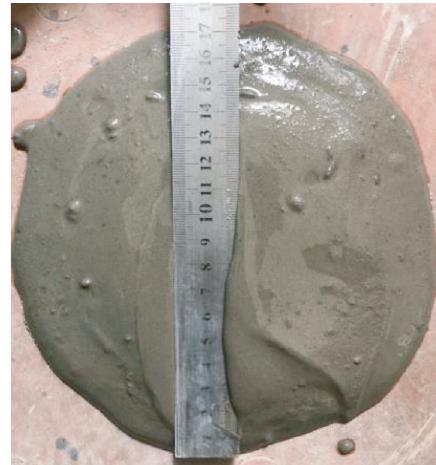
Figure 3: The fluidity test of Aeolian sand-like paste